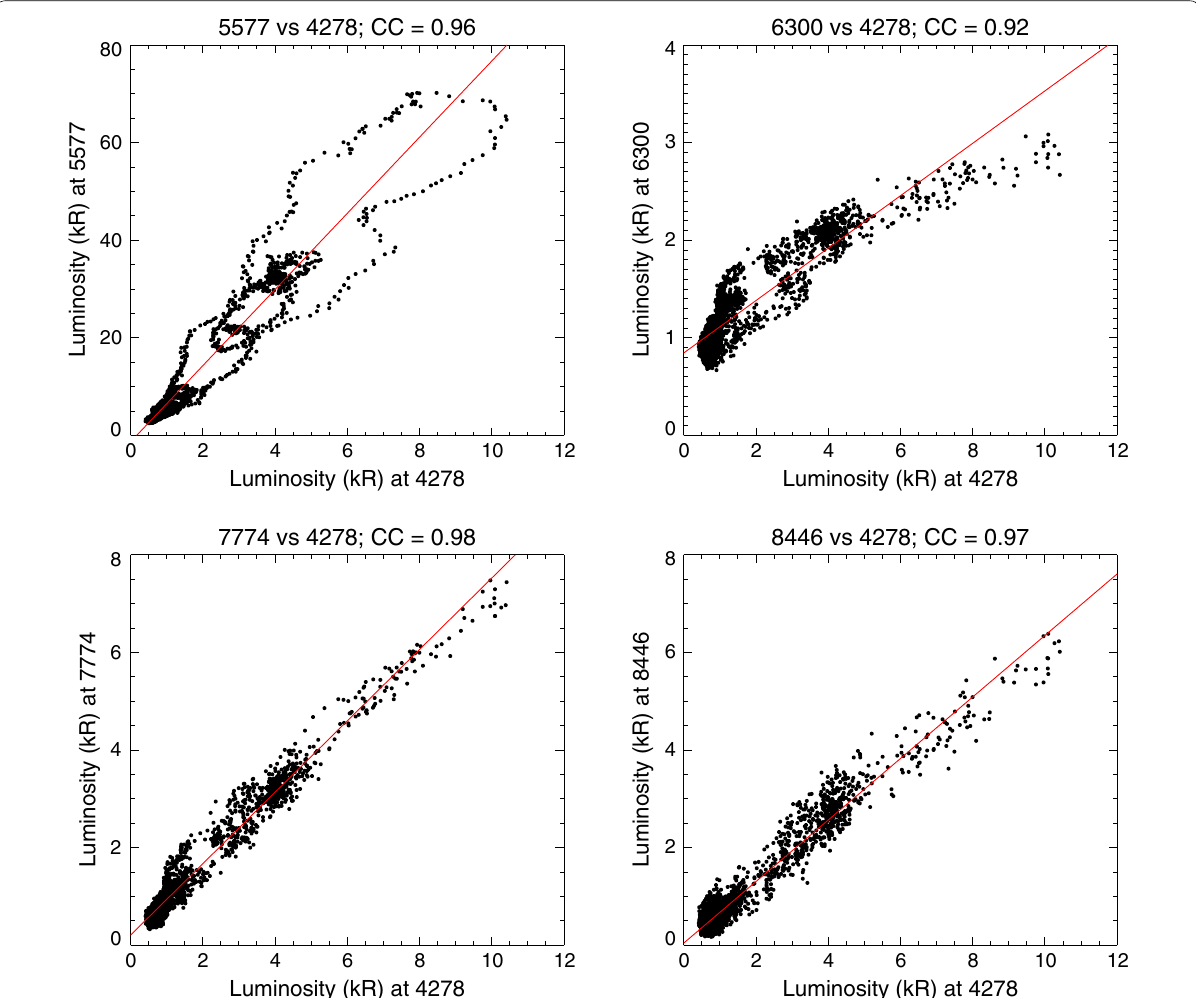
Fig. 18 Scatter plots of auroral intensities (20 Hz data) between 427.8 nm and 557.7 nm (top-left), 630 nm (top-right), 777.4 nm (bottom-left), and 844.6 nm (bottom-right) between 22:33:00 UT and 22:34:00 UT on January 22, 2018. Correlation coefficients (CC) are also shown at each